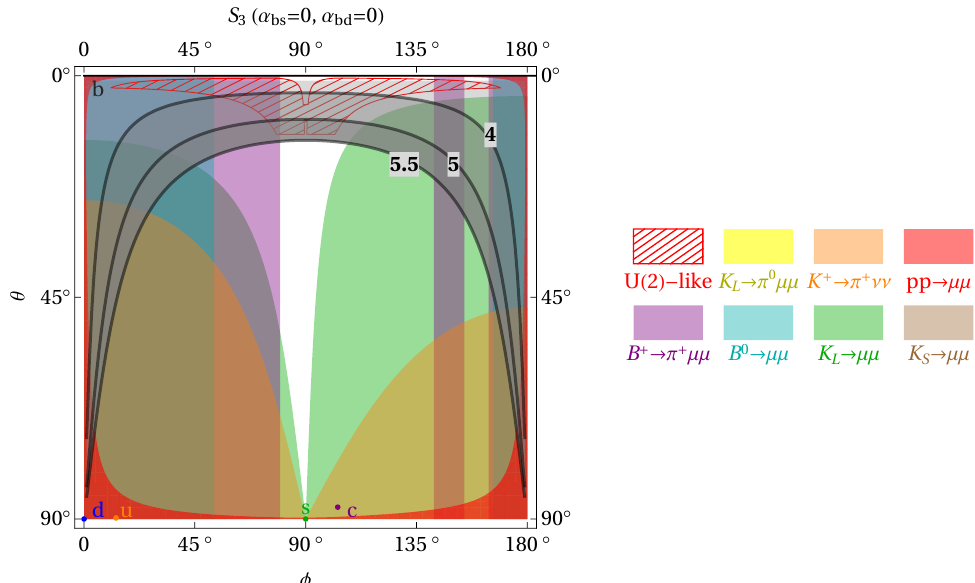
Figure 5 . Constraints on the polar angles θ and φ , which specify the direction of the 3-vector α i (assumed real) of leptoquark couplings, from a variety of correlated flavour observables (updated from [42] with the latest b → s‘‘ fit). The white region is allowed at 2 σ . The black lines are finite naturalness contours with ∆ = 1 , for given values of the leptoquark mass below 5.8 TeV (for which the anomaly-tied correction (3.5) is the dominant one). Above each line, the leptoquark induces a Higgs mass correction greater than 125 GeV or so, and so the model requires fine-tuning. We find that a U(2) -like flavour structure is compatible with finite naturalness (i.e. ∆ . 1 ) for . 5 TeV or so. When M M S S 3 ≥ 5 . 8 TeV there is an inevitable tuning of ∆ ≥ 1 coming from the 3 purely electroweak 2-loop correction (3.7), which is independent of ( θ, φ ) (i.e. independent of the flavour